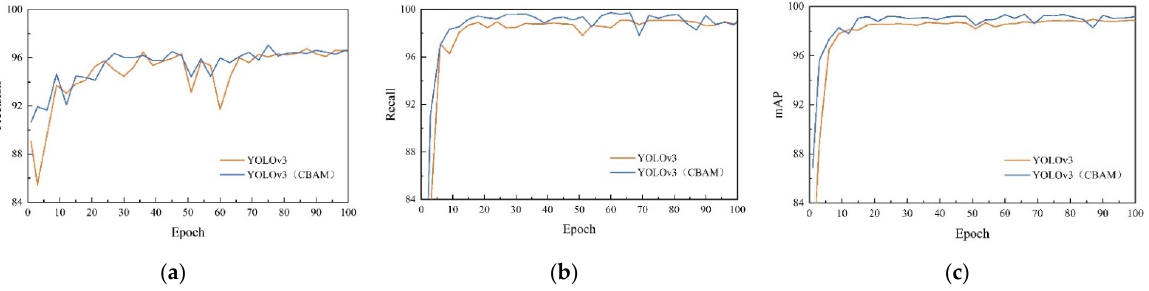
Figure 5. Training results of YOLOv3 and the method proposed in this study:( a ) precision comparison chart; ( b ) recall comparison chart; ( c ) mAP comparison chart. Table 3. Comparison of ablation experiment results.